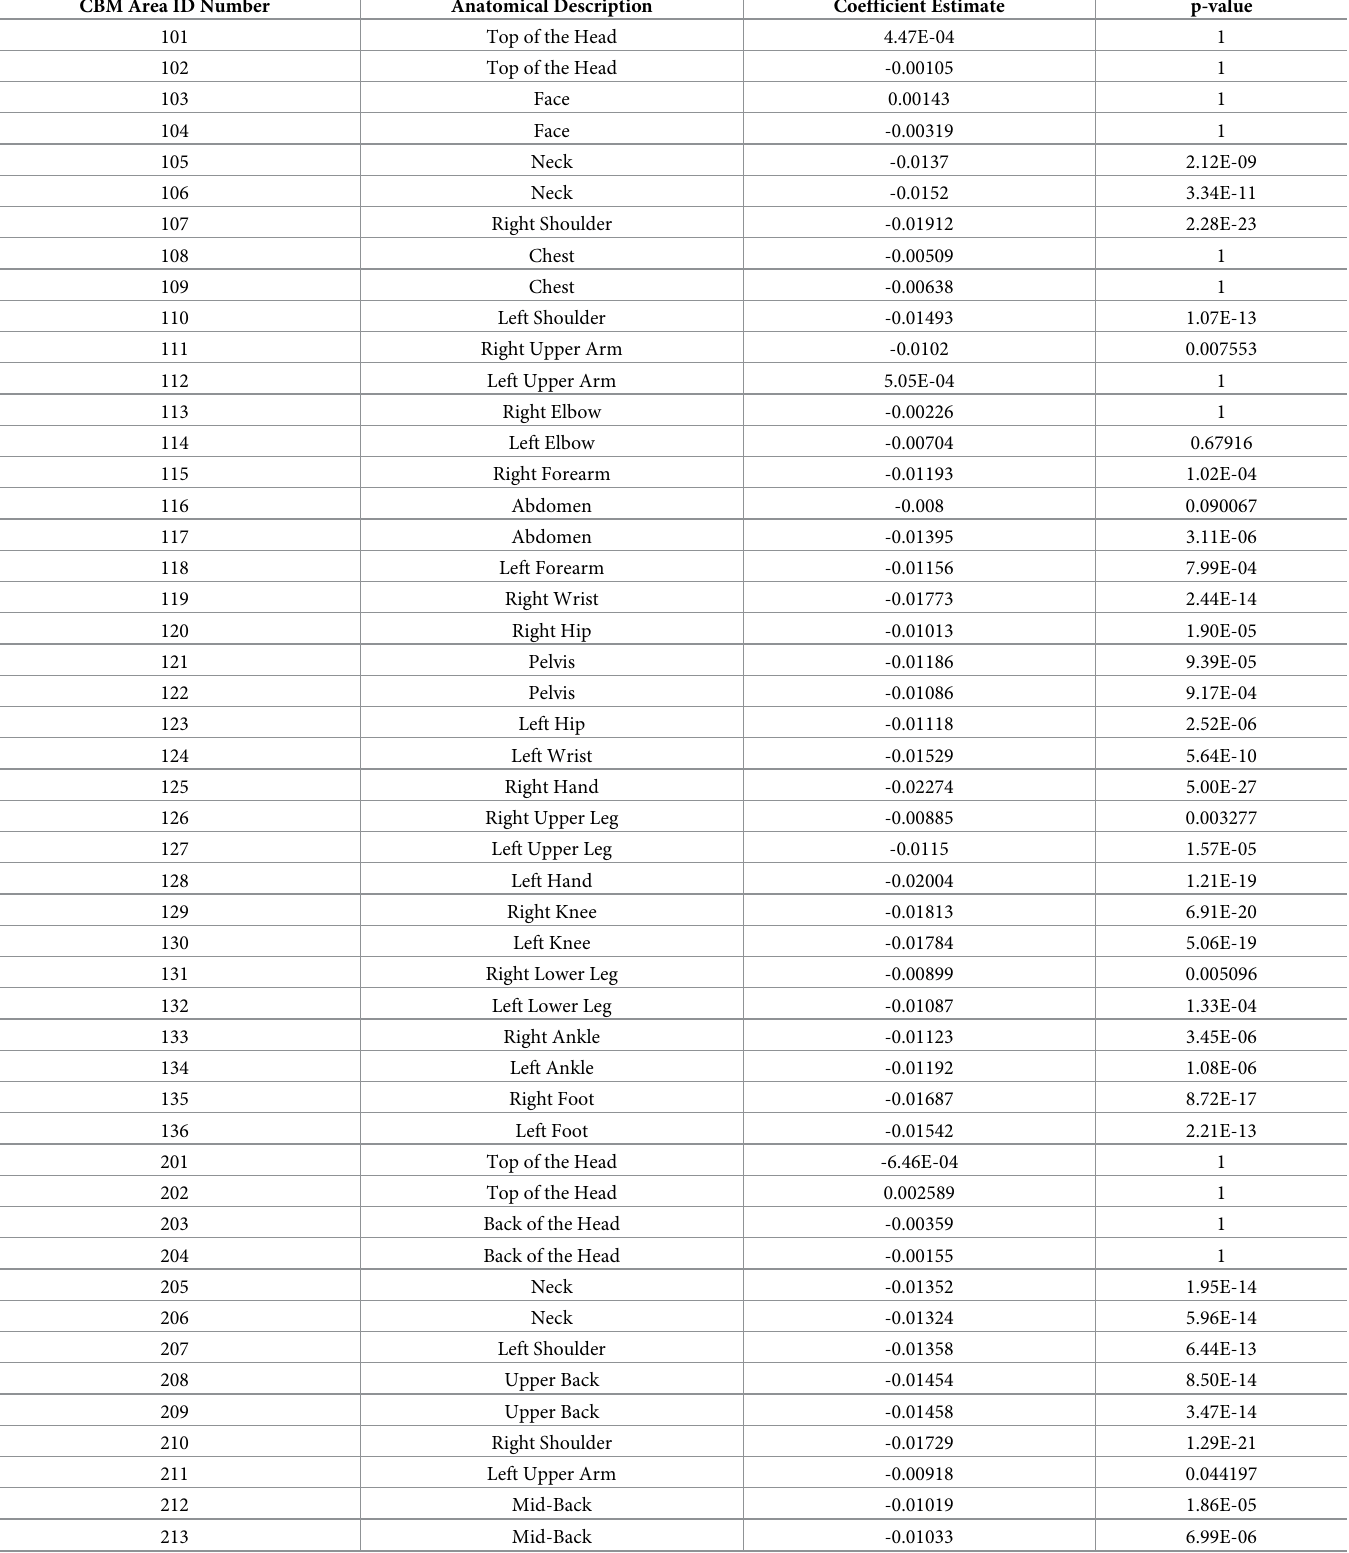
Table 3. The results of logistic regression models for each CBM location to quantify the relationship between PROMIS Emotional Support scores and endorsement of each